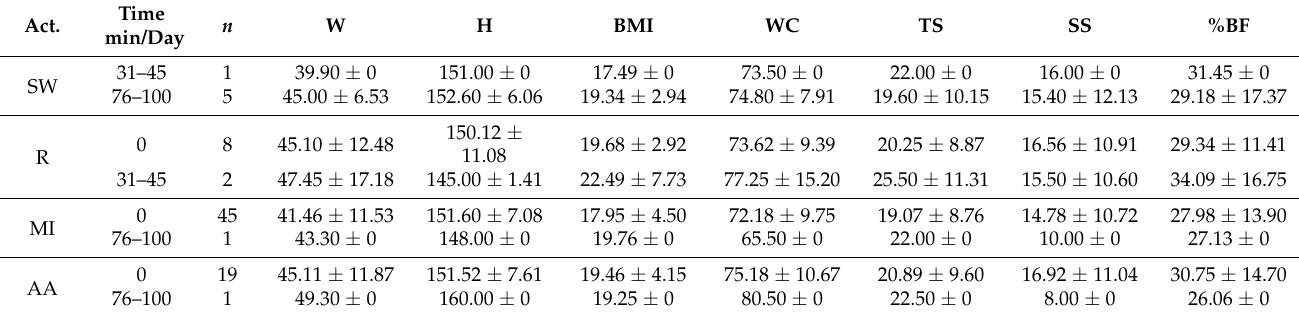
Table 9. Results of post-lockdown anthropometric variables in relation to daily time spent in other sedentary activities.